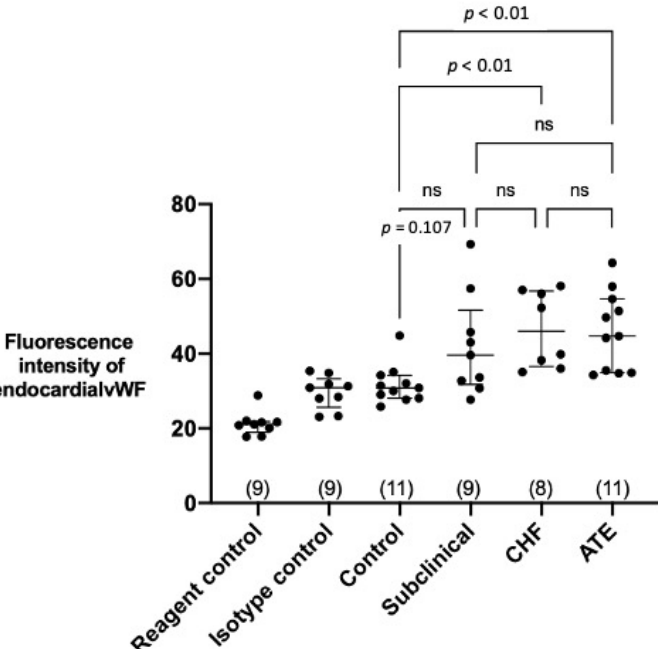
Figure 5. Quantification of the endocardial fluorescence from vWF: Cats with cardiomyopathy and clinical signs showed higher expression of vWF at the endocardium. The fluorescence signals detected in the ATE and CHF group were significantly higher compared to that of control group. No difference was detected between the rest of the groups. “ns” denotes non-significant. The number of cats in each group was shown in brackets. Data were analysed using Kruskal-Wallis test with Dunn’s multiple comparison test. Bars represent median and quartiles.